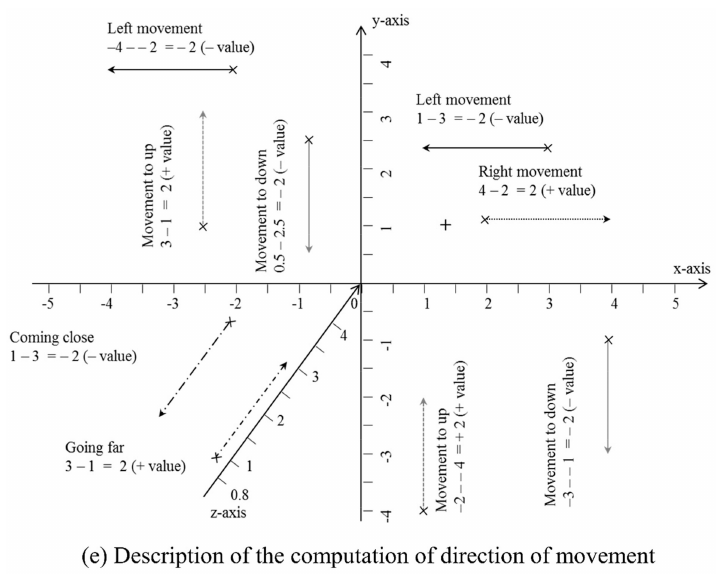
Figure 1. The description for the calculation of the distance for velocity and direction of movement with the coordinate